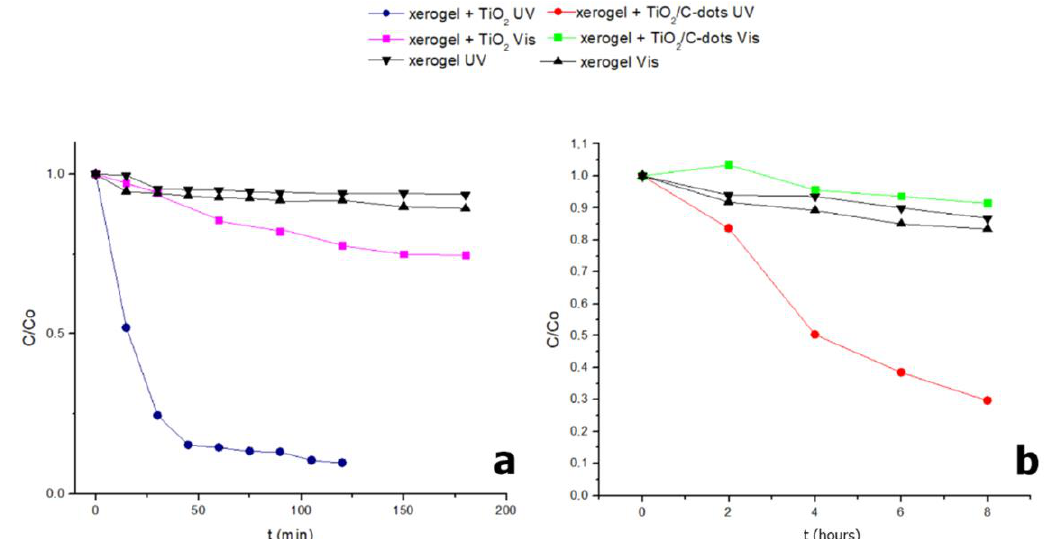
Figure 13. Photocatalytic degradation curves of MO by enhanced xerogels with ( a ) TiO 2 and ( b ) TiO 2 enriched with C-dots under UV and visible irradiation.